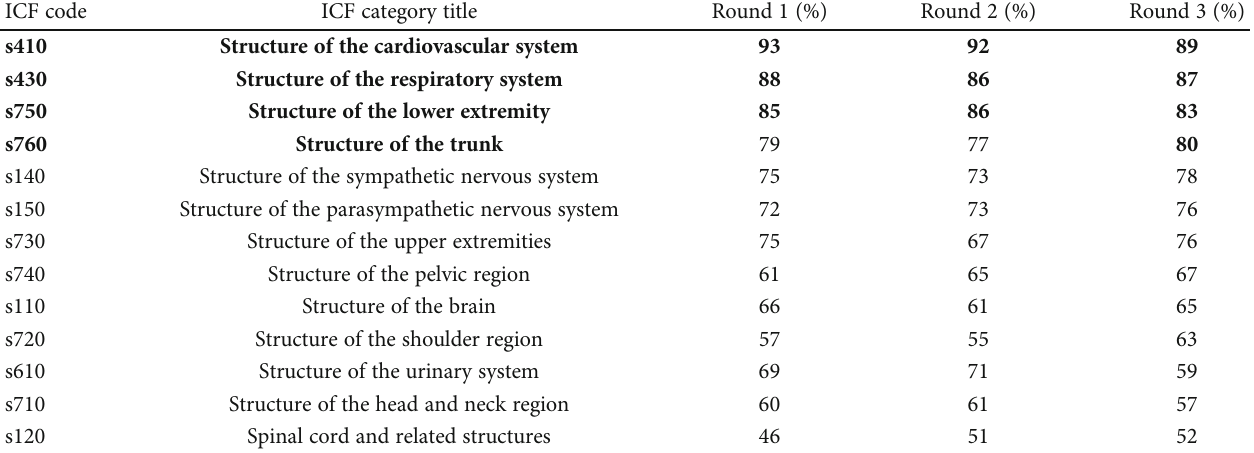
Table 4: International Classi fi cation of Functioning, Disability, and Health (ICF) body structure categories that were considered relevant by ≥ 50% of participants in the third round (items in bold with ≥ 80%